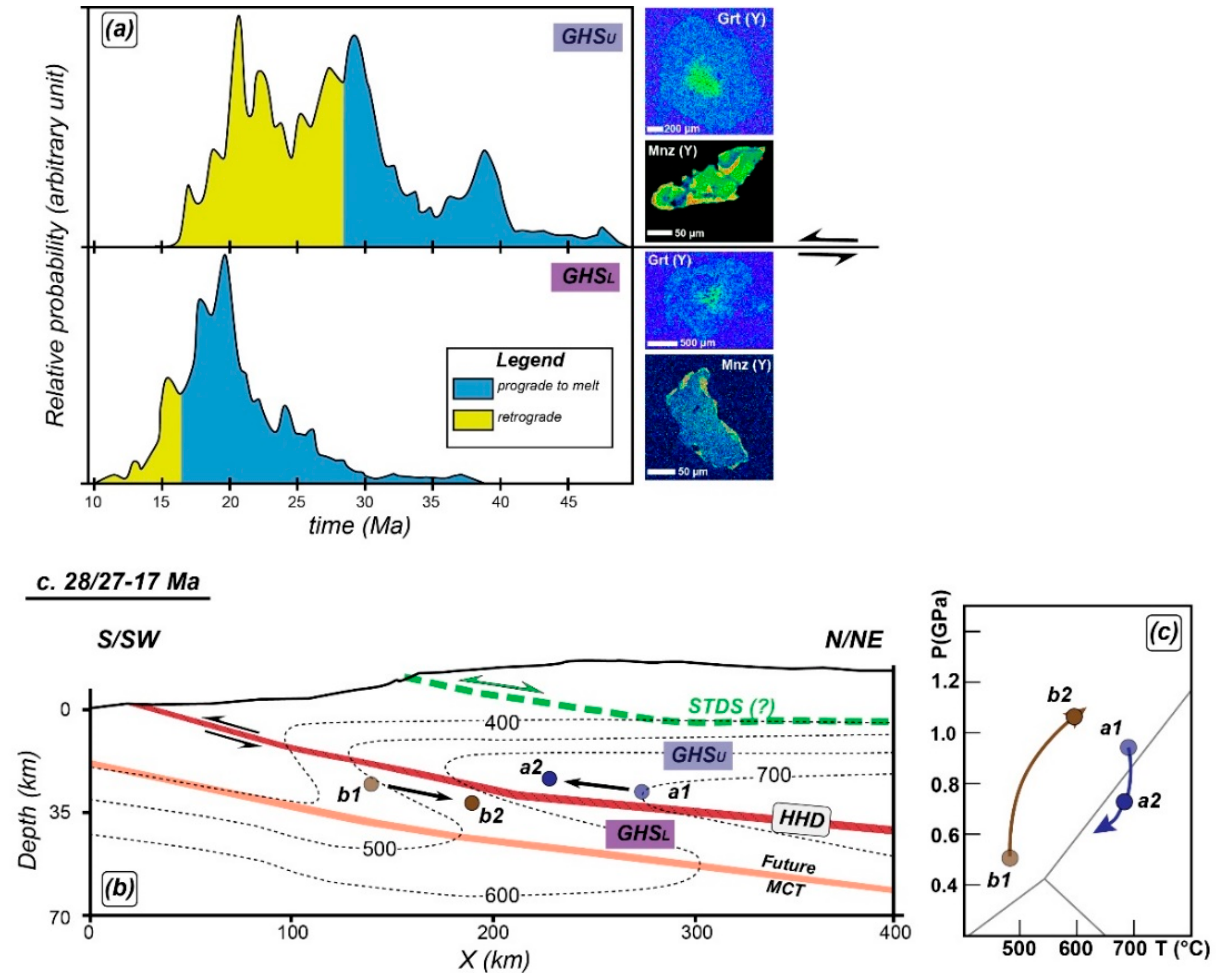
Figure 13. ( a ) Summary of metamorphic (prograde and retrograde) ages of the upper GHS (GHSU) and lower GHS (GHSL) for the Nepalese Himalaya (compilation modified from Wang et al., 2016 [131]). On the right are examples of X-ray maps showing common (and similar) Y zoning in garnet and monazite in the GHSU and GHSL (warm colors point to higher concentrations). ( b , c ) Model for the HHD shearing (in the time span of c. 28/27–17 Ma) affecting the GHS tectono-metamorphic history. ( c ) The HHD, due to its top-to-the-SW kinematics, triggered the earlier exhumation of the GHSU (dots a1 and a2 in ( c )), while the GHSL was still experiencing prograde burial (dots b1 and b2 in ( c )). Exhumation by the thrust-sense shear zone was possible due to a combination of the contemporaneous/episodic activity of the STDS, focused erosion in the frontal part of the belt and tectonic thinning of the GHS caused by non-coaxial flow. Taking into account all of the common features of the recognized discontinuities in western-central Nepal up to Sikkim and Bhutan to the east, Montomoli et al. (2015) [116], Wang et al. (2016) [131] and Carosi et al. (2018; 2019) [127,130] correlated the discontinuities in the Himalaya along-strike length for ~1000 km (Figure 2). Benetti et al. (2021) [128],